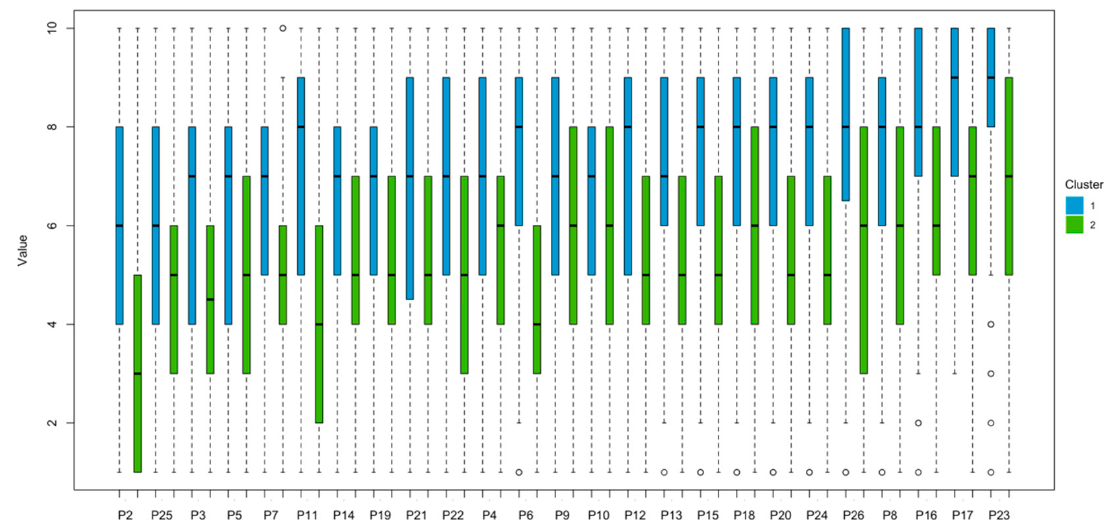
Figure 6. Summary of responses by cluster to questions with categorical responses from multiple categories. Source: compiled by the authors.